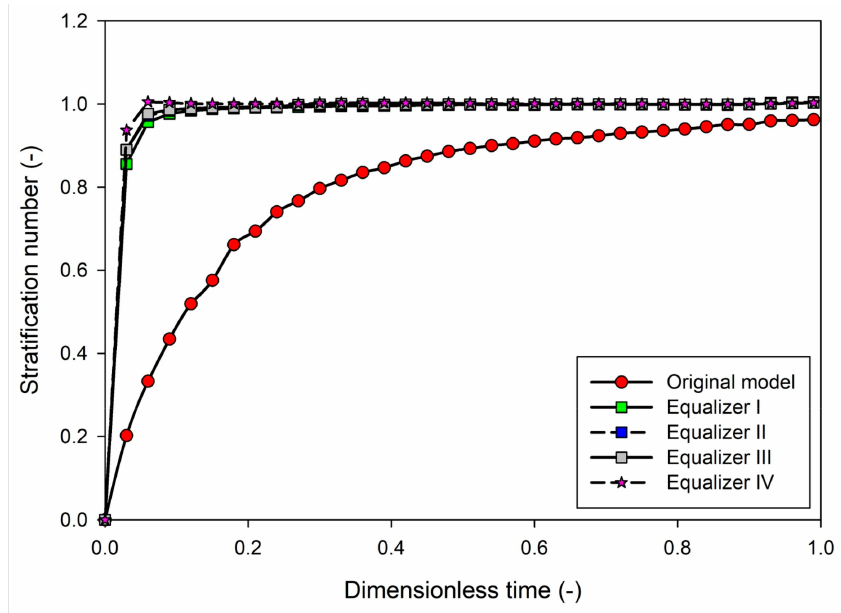
Figure 14. The stratification numbers of the equalizer models. To confirm the degree of temperature stratification, the temperature contours and the velocity profiles are depicted in Figures 15 and 16, respectively. It showed the corresponding results to the Richardson number and the Stratification number. At the dimensionless time of 0.1, the equalizer IV model presented a clear thermocline and a large amount of cold water existing at the lower part of the storage tank, which indicated superior temperature stratification. The analytical results corresponded to the velocity profile. From the results, the equalizer diameter enlargement was the main parameter impacting temperature